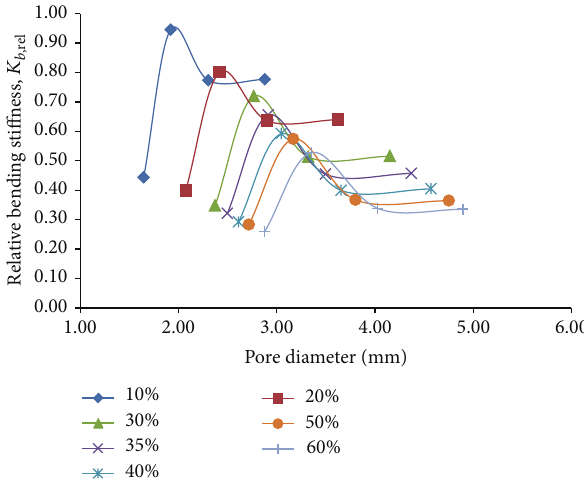
Figure 10: Plots depicting variation of pore efficiency under com- pressive loading, 𝜇 𝑐 , with pore diameter, for different percentages of porosity for 3D porous FE cubic models subjected to compressive loading only.